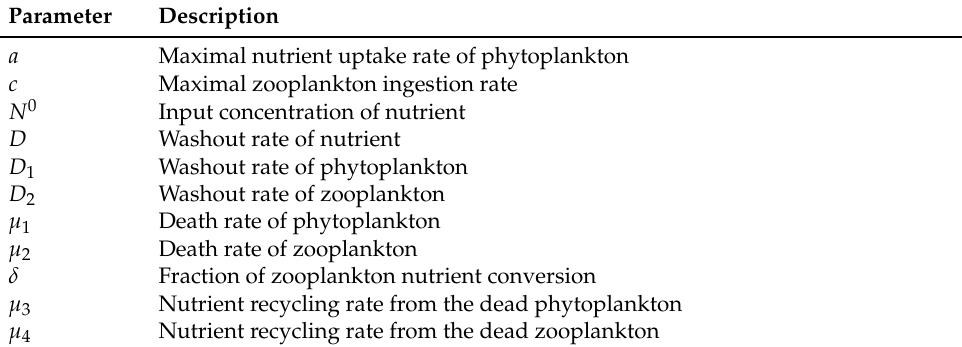
Table 1. Biological explanation of parameters in model